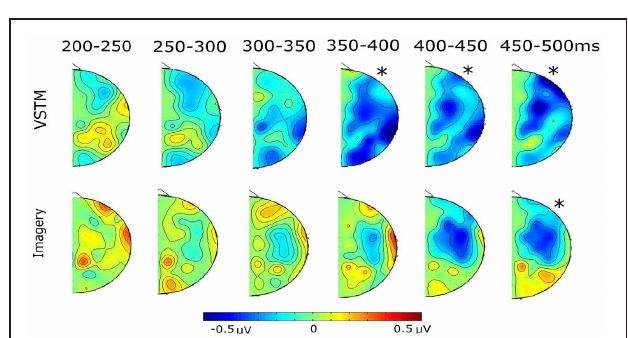
FIGURE 5 | The topographical distribution of the contra-ipsilateral differences (contra minus ipsi) for each condition, running from 200ms onwards, in 50ms bins. In all cases the “ ∗ ” indicates significant time-bins from the earlier statistical analysis.